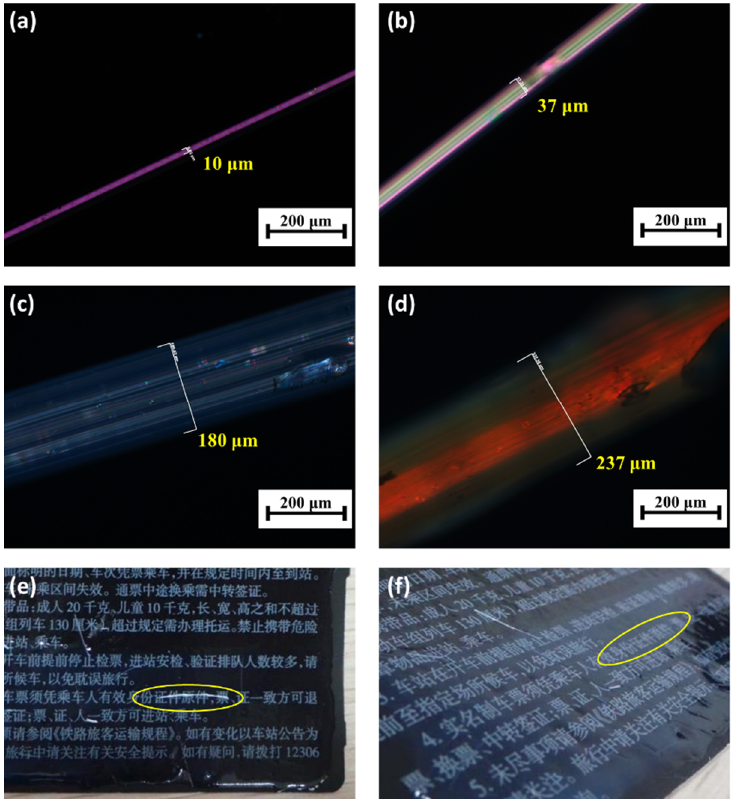
Figure 6. ( a–d ) Optical microscopic image of the fibers made from the side-chain liquid crystal co-polymer 3HG2080; ( e , f ) photographs of the fiber from different viewing angles.